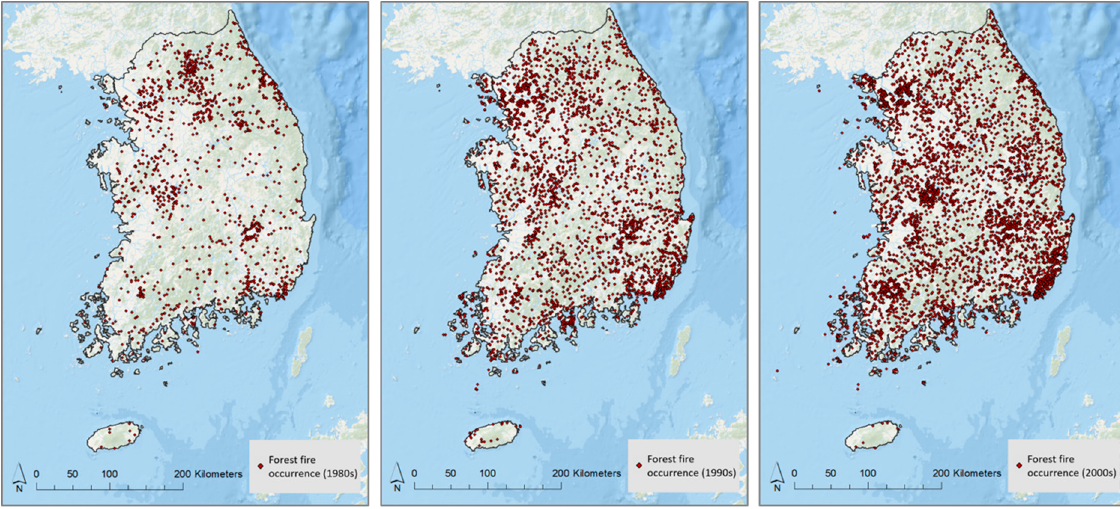
Figure 4. Location of forest fire occurrences during the 1980s, 1990s, and 2000s.